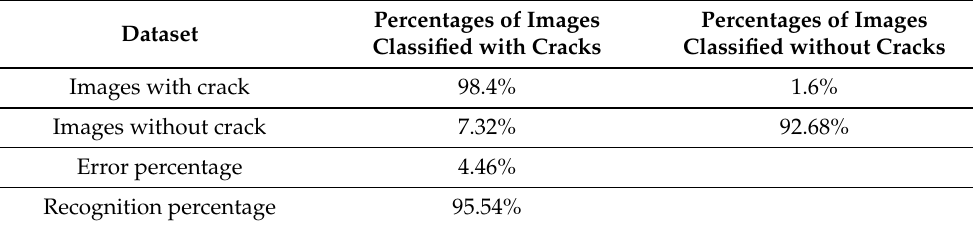
Table 4. Results of